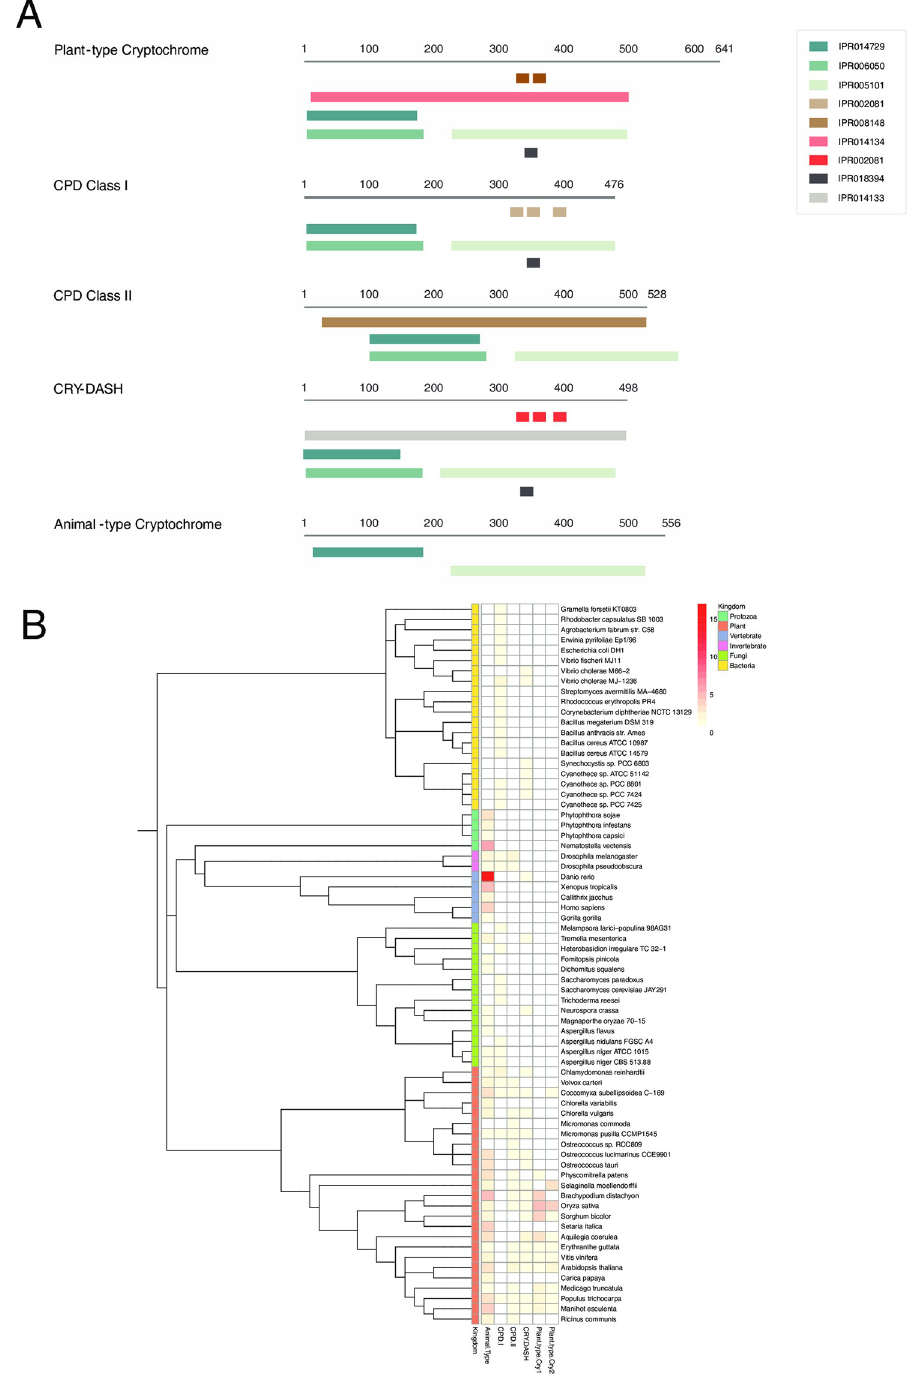
Fig 4. Interkingdom comparative analysis of the photolyase/cryptochrome gene family. (A) Domain architectures of the photolyase/cryptochrome gene family. (B) Taxonomic distribution of photolyase/cryptochrome genes.